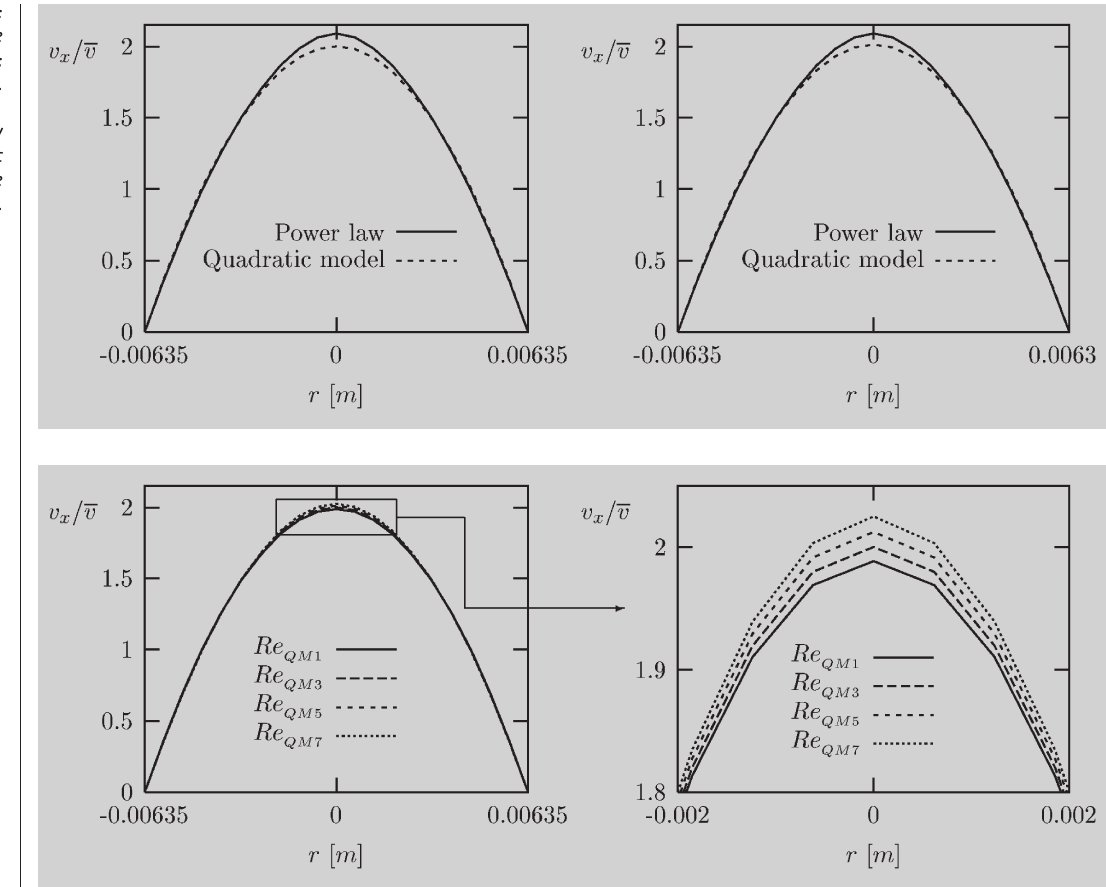
Figure 8 (above): Velocity profile (left: v– = 0.307 m/s; right: v– = 0.753 m/s). Figure 9 (below): Velocity profiles using Quadratic model depending on the Reynolds